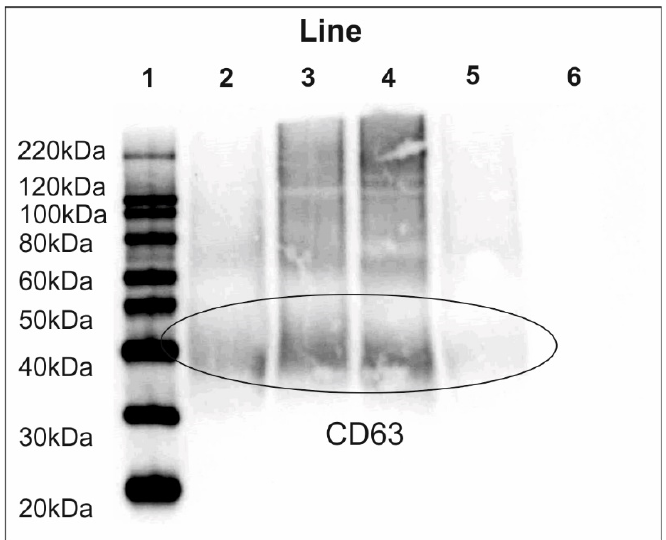
Figure 1. Western blot for human CD63 detection in astrocyte-derived exosome lysates. Exosomes were separated from supernatants of cell culture medium. Line 1—molecular marker (Invitrogen Magic Mark XP, Invitrogen, Waltham, MA, USA), lines 2–5: RIPA lysates of exosomes (2.0 µg of total protein/line) isolated from culture medium after human primary astrocytes stimulation with TGF- β (2), IL-10 (3), proinflammatory cytokines TNF α /IL-1a/C1q (4), culture medium alone (5). Line 6—cell lysate from astrocytes.